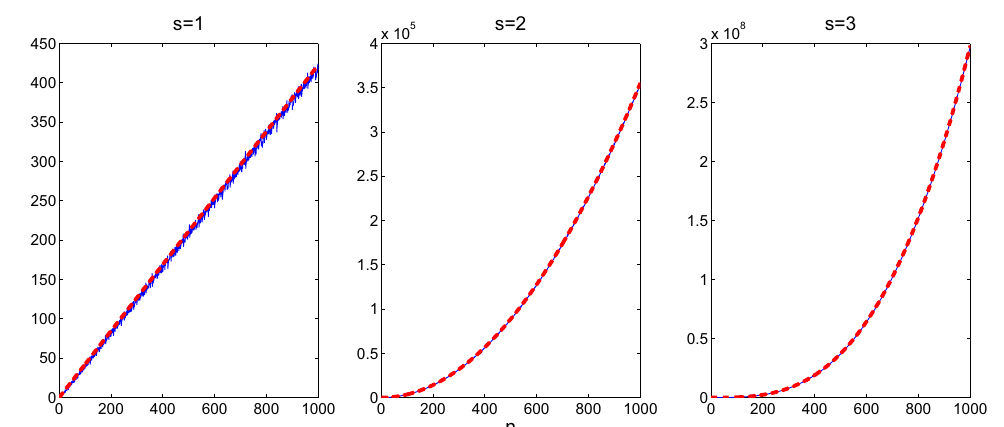
Fig. 1 A comparison between the values of (cid:8) s ( n ) marked in blue and the asymptotic expression derived in Theorem 4.2 marked in red . The x -axis is n while the y -axis is (cid:8) s ( n ) . The left , middle , and right figures correspond to s = 1 , s = 2 and s = 3,